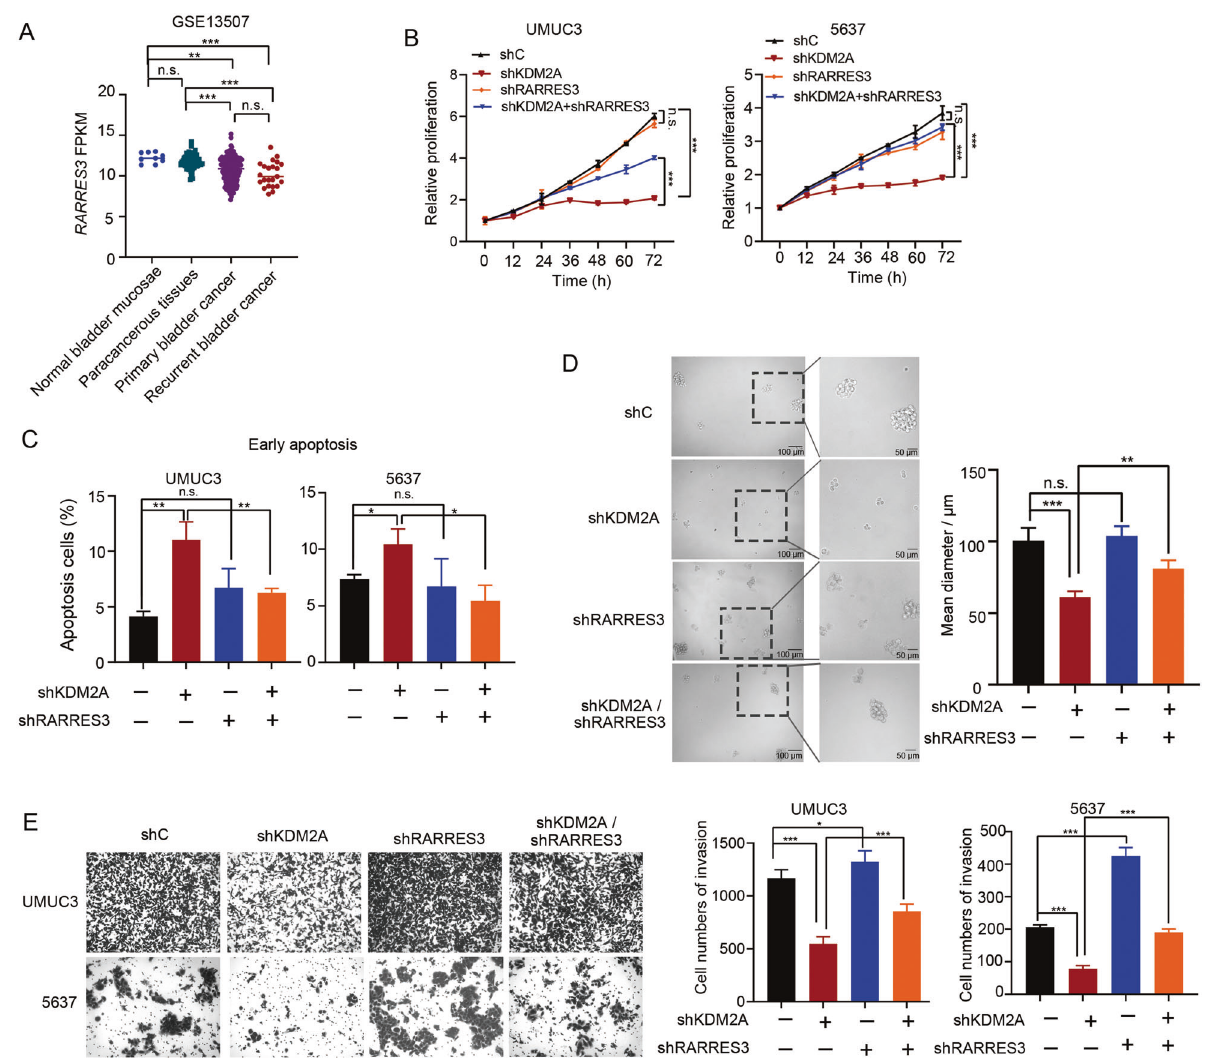
Fig. 5 Suppression of RARRES3 contributed to the cell invasion function of KDM2A. A Analysis of RARRES3 expression level in bladder cancer tissues and normal bladder tissues in GEO database (GSE13507). B Cell viability of KDM2A KD cells with or without RARRES3 KD. C Early apoptosis analysis upon KDM2A KD and RARRES3 KD separately or simultaneously. D Sphere forming assay was performed on KDM2A KD UMUC3 cells with or without RARRES3 KD. The sphere size was measured at day seven. E Invasion assay was performed upon silencing KDM2A and RARRES3 separately or simultaneously. Cell invasion was assessed by counting the number of migrated cells after 24 h. * P < 0.05; ** P < 0.01; *** P < 0.001 is based on the Student ’ s t test. All results are from more than three independent experiments. Values are mean ±